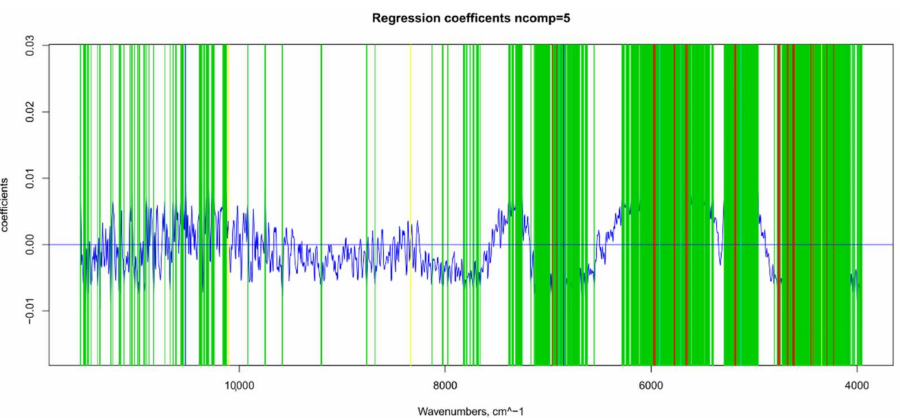
Figure 13. Beta-coefficient values after outlier removal and mean center: values selected for ANN (in green), main NIR peaks for water (in blue), sugar and water (in light blue), sugar and organic acids (in yellow), and pectins (in